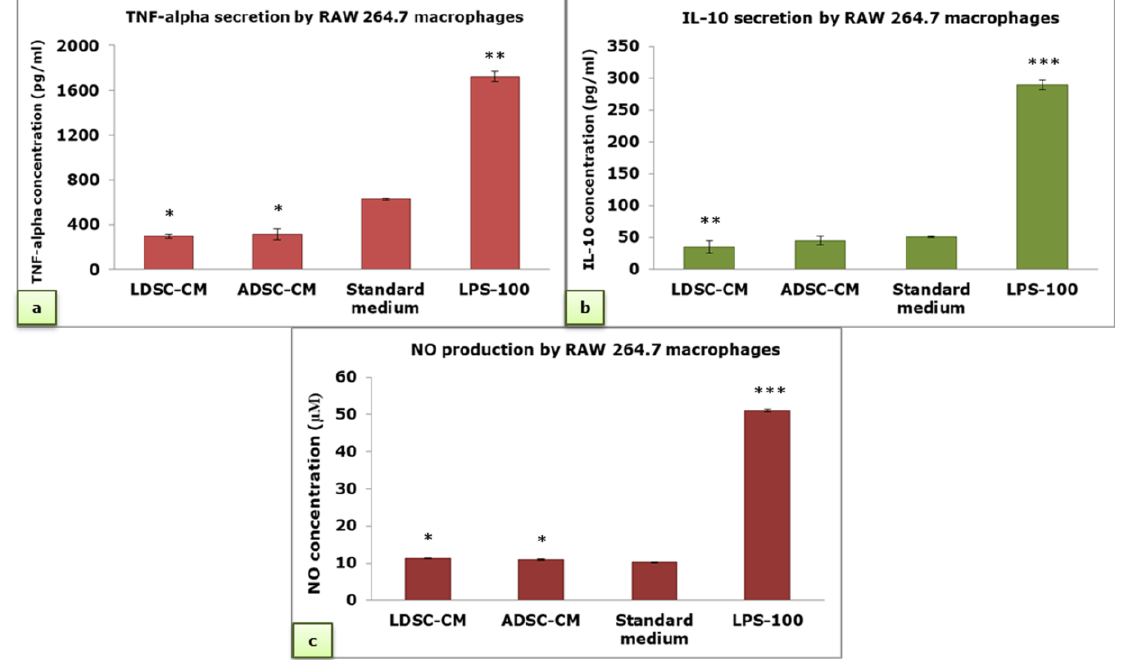
Figure 6. TNF-alpha ( a ), IL-10 ( b ) and NO concentration ( c ) in cell culture supernatant of RAW 264.7 macrophages cultured for 48 h in LDSC-CM, ADSC-CM, standard medium and LPS-100; mean ± standard deviation (SD); sample size: n(LDSCs) = 4 and n(ADSCs) = 4 (n − number of patients per group); for each patient sample culture-derived CM, as well as controls, four replicates were analyzed; (*) p < 0.05, (**) p < 0.01, (***) p < 0.001 (compared to standard medium).